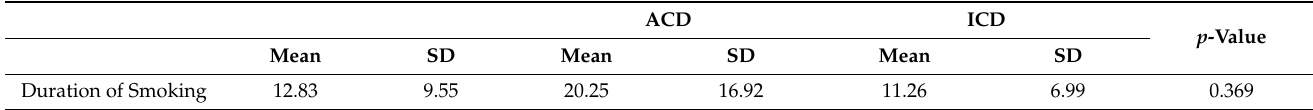
Table 5. The association between mean smoking duration and either ACD or ICD.